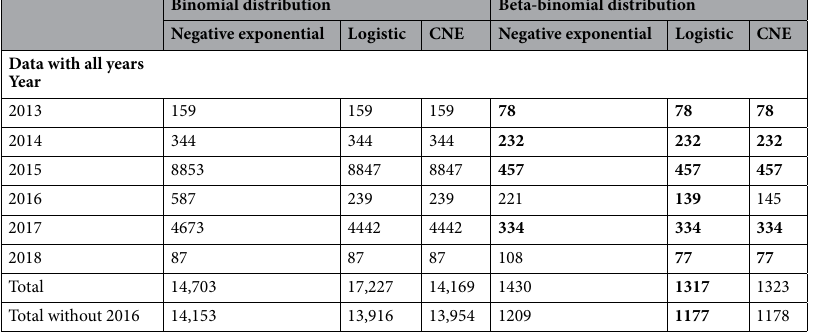
Table 2. Akaike information criterion (AIC) for the logistic and constrained exponential model when fitted to data for each year separately. Bold values are the lowest AIC values within a row. CNE constrained negative